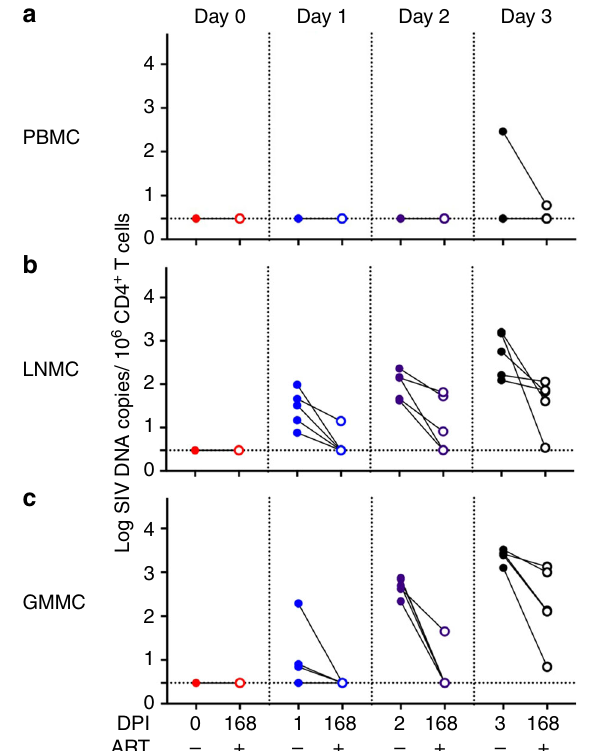
Fig. 2 SIV DNA in blood and tissues pre-ART and at ART discontinuation. Cell-associated SIV DNA in a peripheral blood mononuclear cells (PBMC), b lymph node mononuclear cells (LNMC), and c gastrointestinal mucosa mononuclear cells (GMMC) in animals that initiated ART on days 0, 1, 2, and 3 following infection. Log SIV DNA copies/10 6 total CD4 + T cells is shown. Changes in levels of viral DNA prior to ART and at the time of ART discontinuation were compared using a Wilcoxon rank sum test. p values are not signi fi cant unless they are indicated. Assay sensitivity, as indicated by the hatched line, is <3 copies/10 6